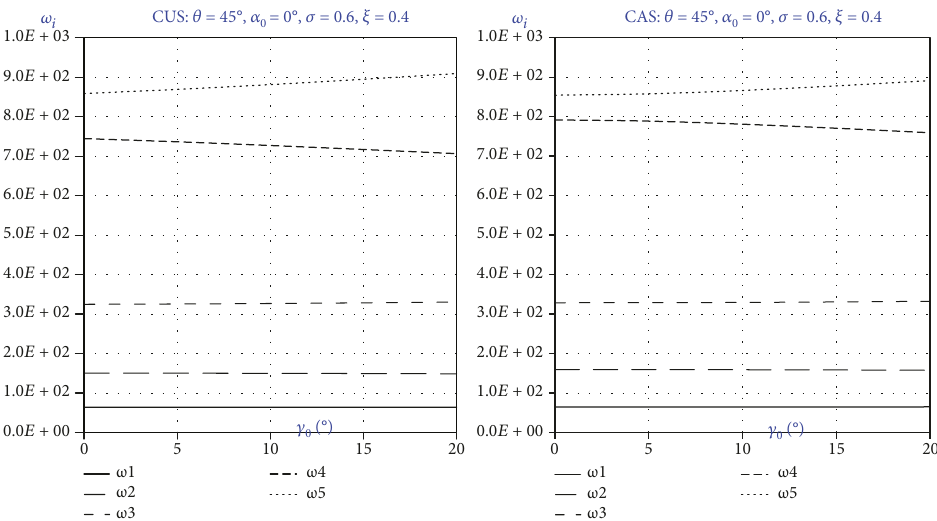
Figure 13: Eigenfrequencies vs. ply angle of Model A via γ